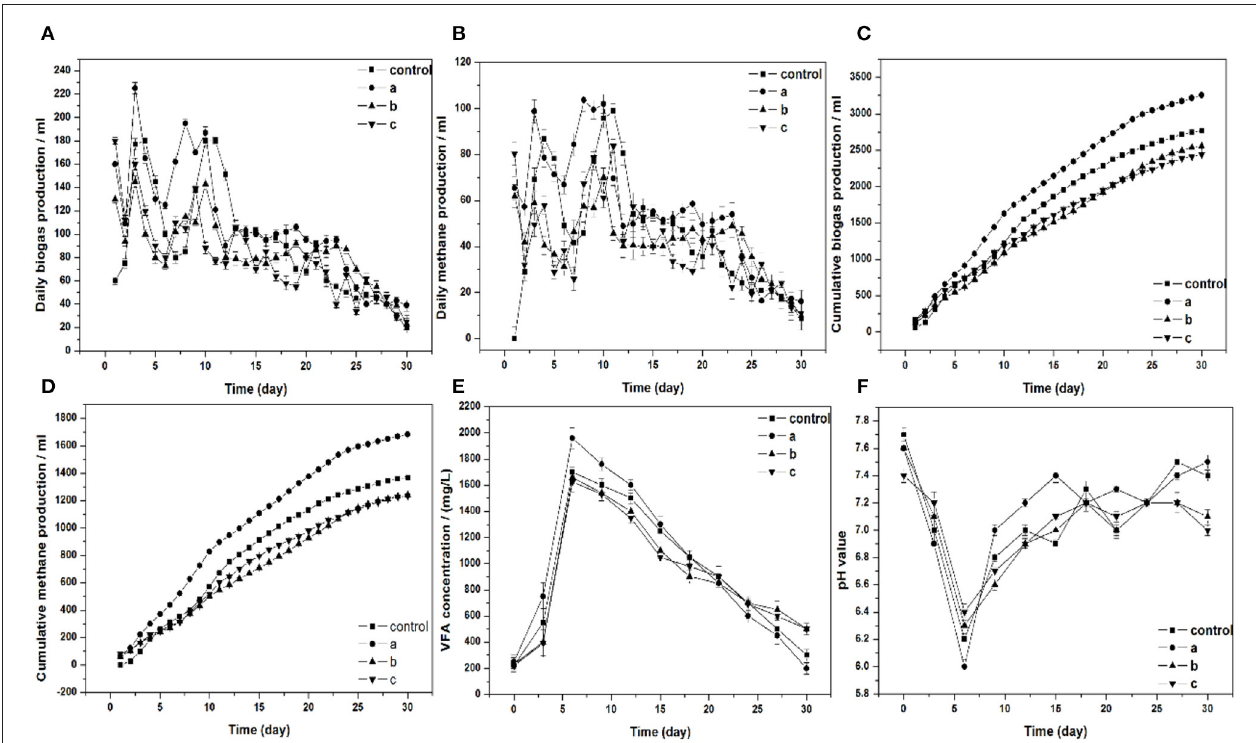
FIGURE 1 | (A) Daily biogas production, (B) daily and cumulative methane production, (C) cumulative biogas production, (D) cumulative methane production, (E) VFA concentration, (F) pH value, respectively, in batch fermentation from wheat straw affected by adding different ratios of Am residues (a, b, and c: the ratios of Am residues/wheat straw are 3, 5, and 10%,